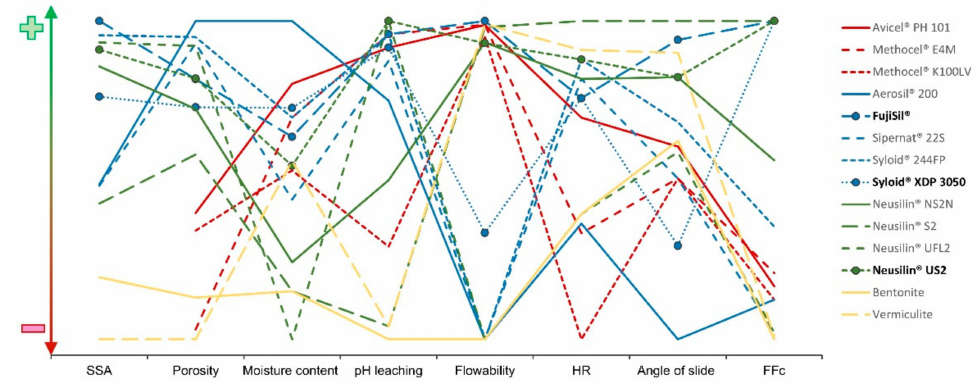
Figure 2. Comparison of selected results of powder carriers represented by graphical